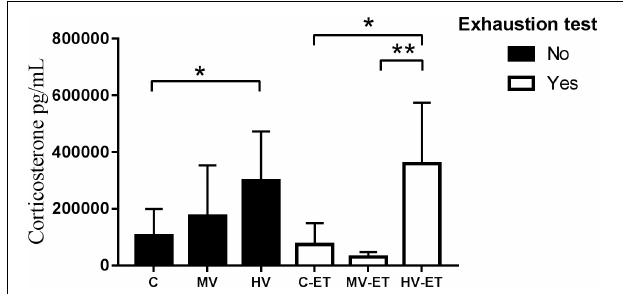
FIGURE 4 | Corticosterone levels in the serum. HV vs. C ( P = 0.038). HV-ET vs. MV-ET ( P = 0.002) and C-ET ( P = 0.013). C, control group; C-ET, control + exhaustion test group; MV, moderate-volume group; MV-ET, moderate-volume + exhaustion test group; HV, high-volume group; HV-ET, high-volume + exhaustion test group. * P ≤ 0.05; ** P < 0.01. Values represent mean ± S.D. All the experiments were carried out in triplicate.